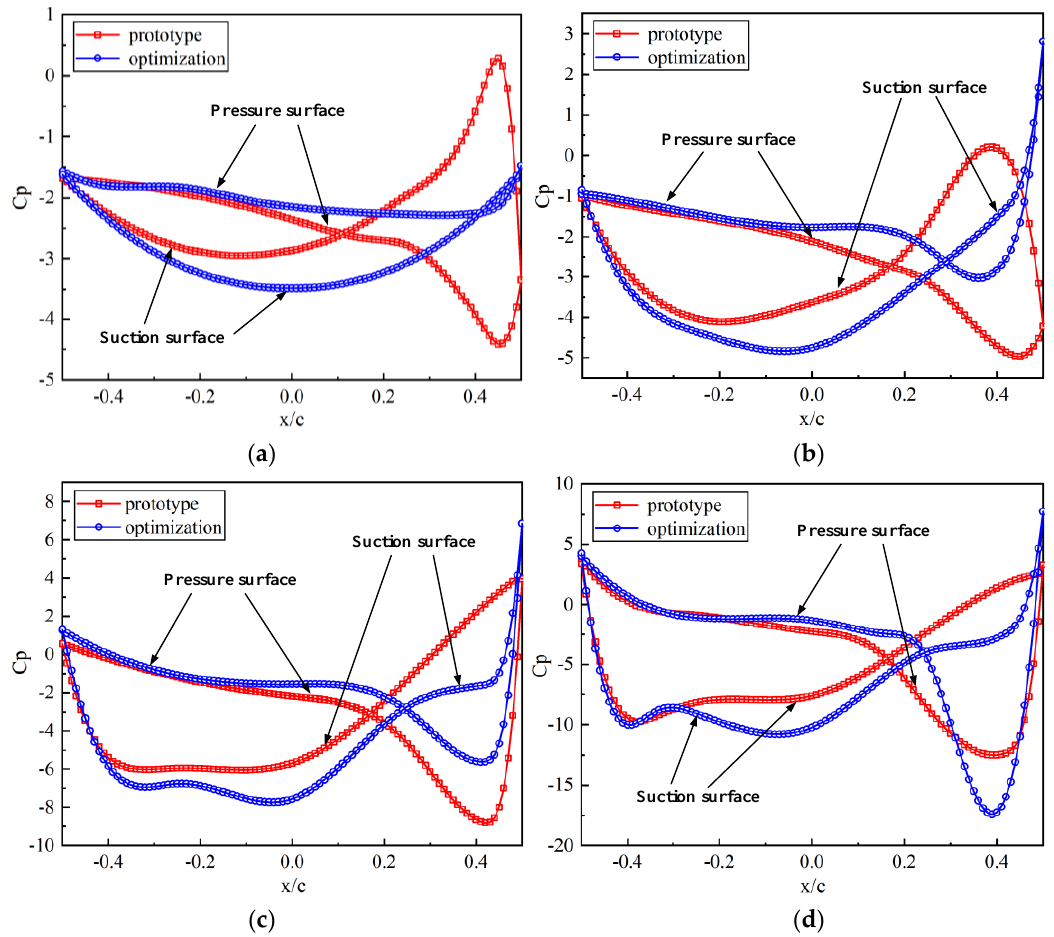
Figure 11. Pressure coefficient at different sections ( J = 0.7): ( a ) 0.3 R, ( b ) 0.5 R, ( c ) 0.7 R and ( d ) 0.9 R.